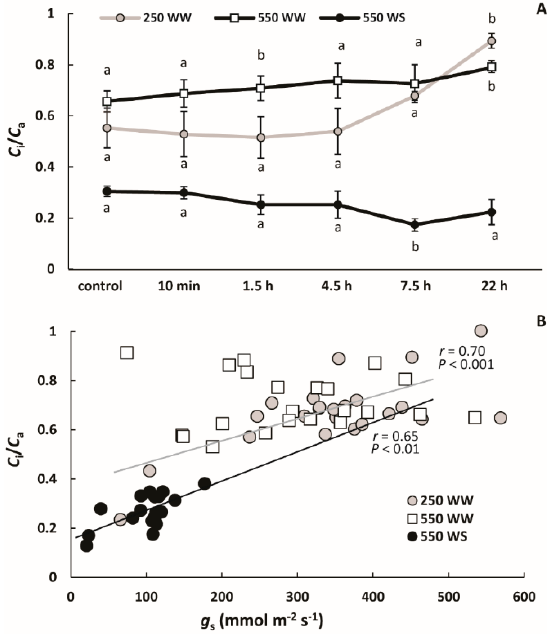
Figure 4. The ratio of mean ± SE intercellular CO 2 ( C i ) to ambient CO 2 concentration ( C i / C a ; C a = 380–400 µmol mol − 1 during the measurements) after O 3 fumigation ( A ) and correlations among C i / C a with stomatal conductance to water vapor ( g s ) through recovery (10 min, 1.5 h, 4.5 h, 7.5 h and 22 h after O 3 exposure; ( B ) in B. nigra . In A, the data are labelled as: grey continuous line with grey circles—well-watered (WW) plants treated with 250 ppb O 3 ; black continuous line with white squares—WW and 550 ppb O 3 ; black continuous line with black circles—water-stressed (WS) and 550 ppb O 3 . In B, each data point indicates an individual measurement and the symbols are as: grey circles—WW/250 ppb O 3 ; white squares—WW/550 ppb O 3 ; black circles—WS/550 ppb O 3 . In A, the means at different recovery time-points within treatments were compared by paired sample t-tests, significant differences ( p < 0.05) are indicated by lowercase letters. In B, the data were fitted by linear regressions, and the regression lines are shown for the significant relationships ( p < 0.01 for WW/250 ppb O 3 (grey line), and WS/550 ppb O 3 (black line).